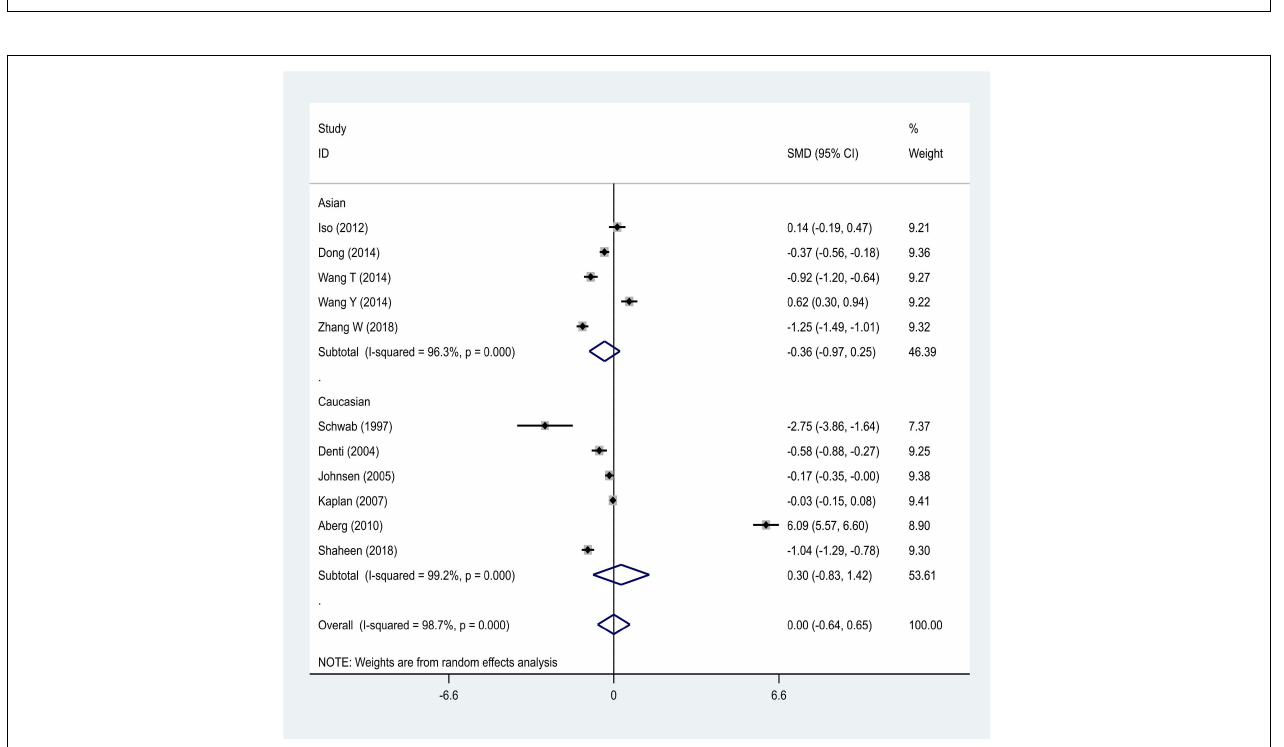
Frontiers in Aging Neuroscience |